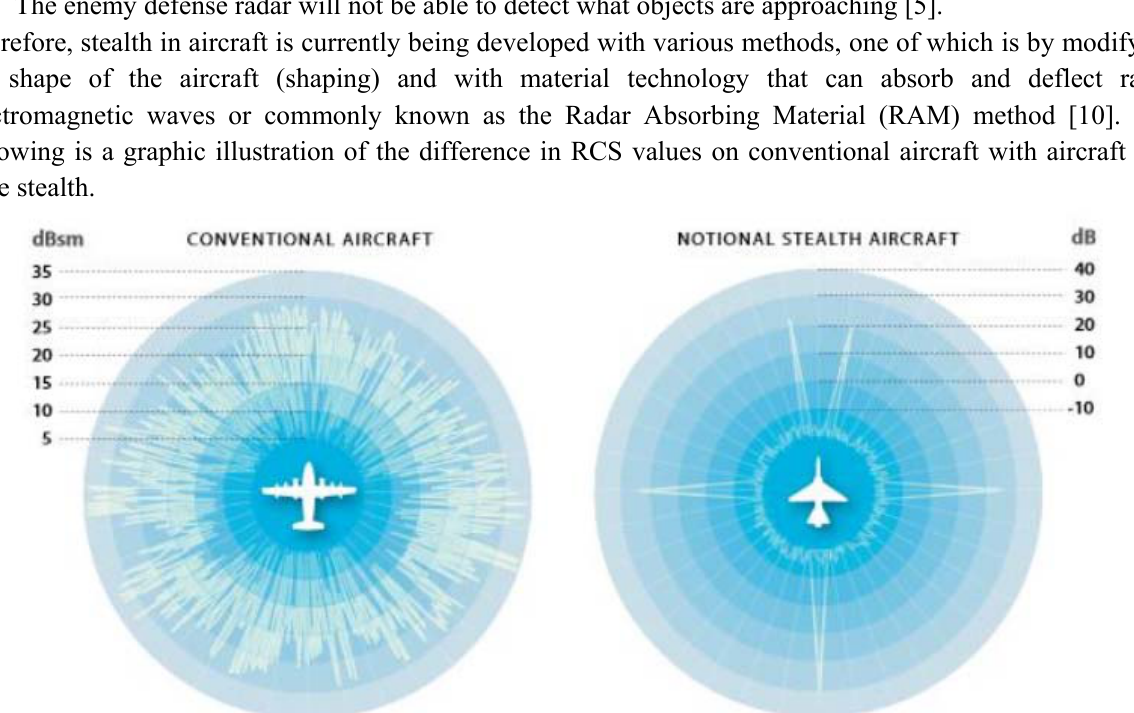
Figure 1. Graph of comparison of RCS values between conventional aircraft (20 dB) and stealth (-10 dB)